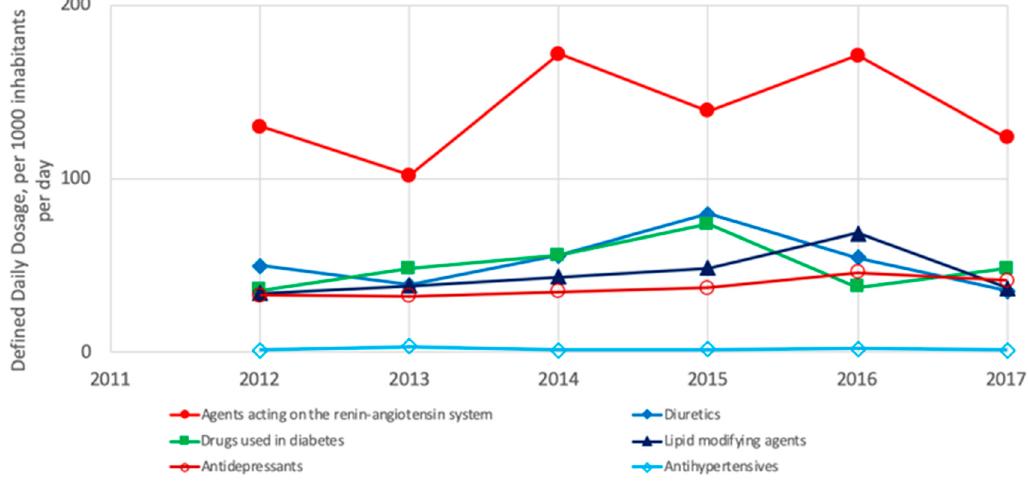
Figure 15. Most consumed pharmaceuticals in OECD Latin American countries from 2011 to 2017 [3].